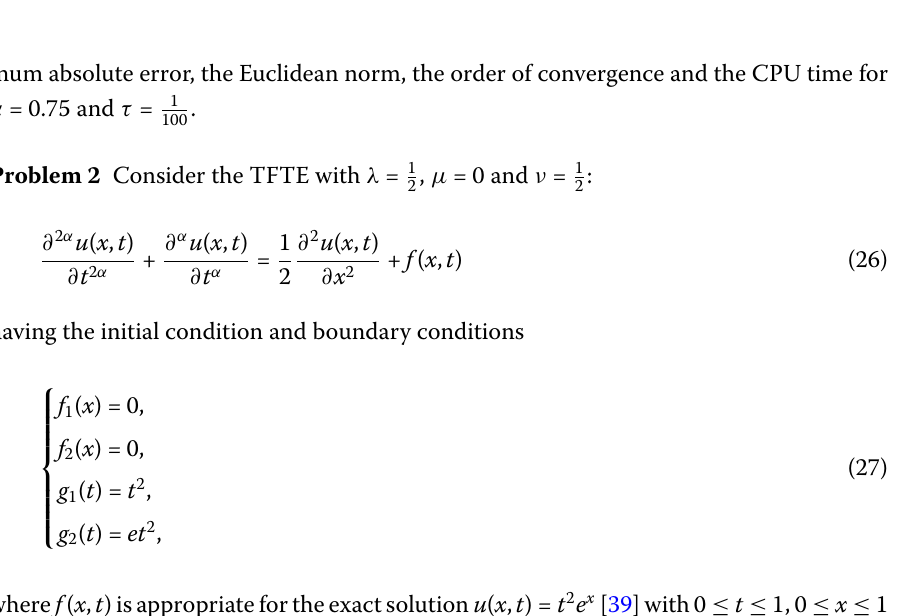
Table 3 A comparison of maximum error with h = 5 τ = 1 α